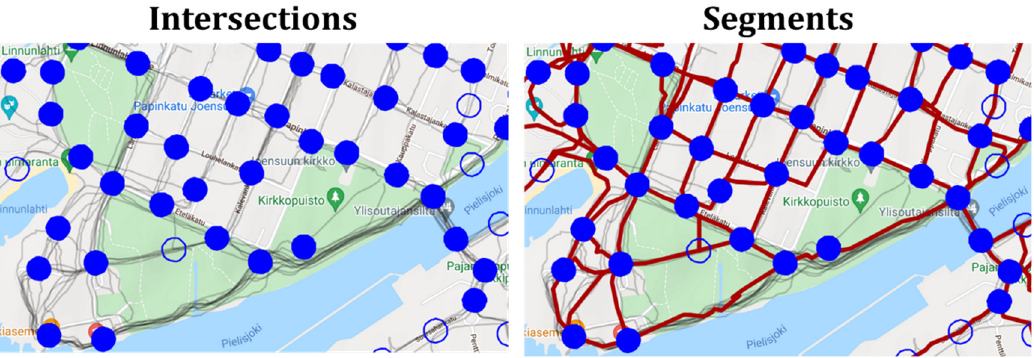
Figure 1. Extracting road network from GPS trajectories needs segment averaging to convert a set of trajectories between two intersections to a road segment.